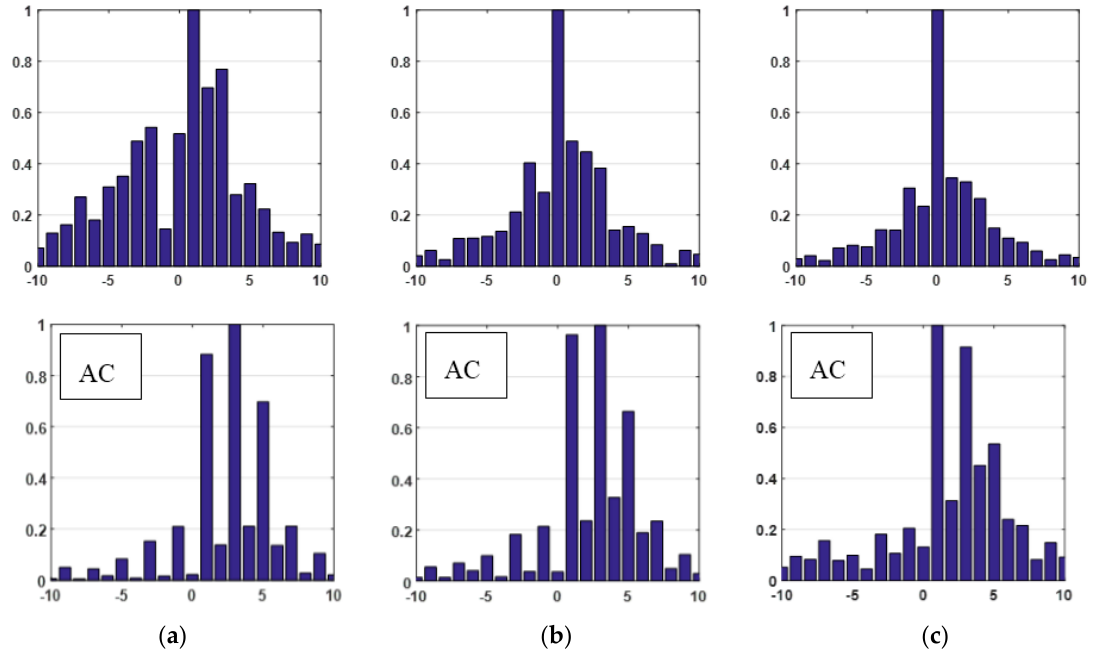
Figure 9. Crosstalk distribution of electromagnetic vortex waves with transmission distance of ( a ) 1 km, ( b ) 5 km and ( c ) 10 km under moderate-to-strong turbulence conditions.